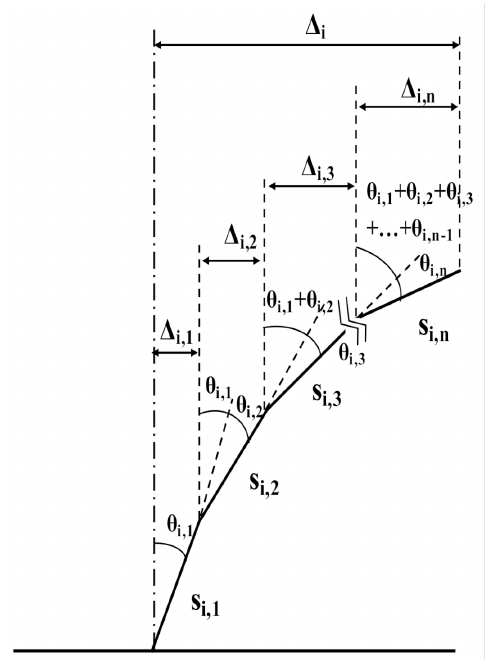
Figure 9. Calculation method of